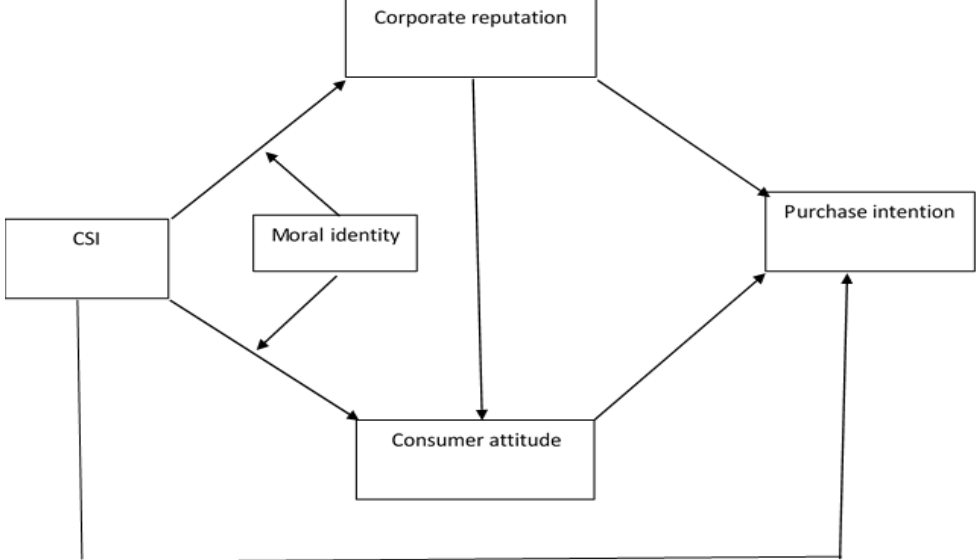
Figure 1 : The model of